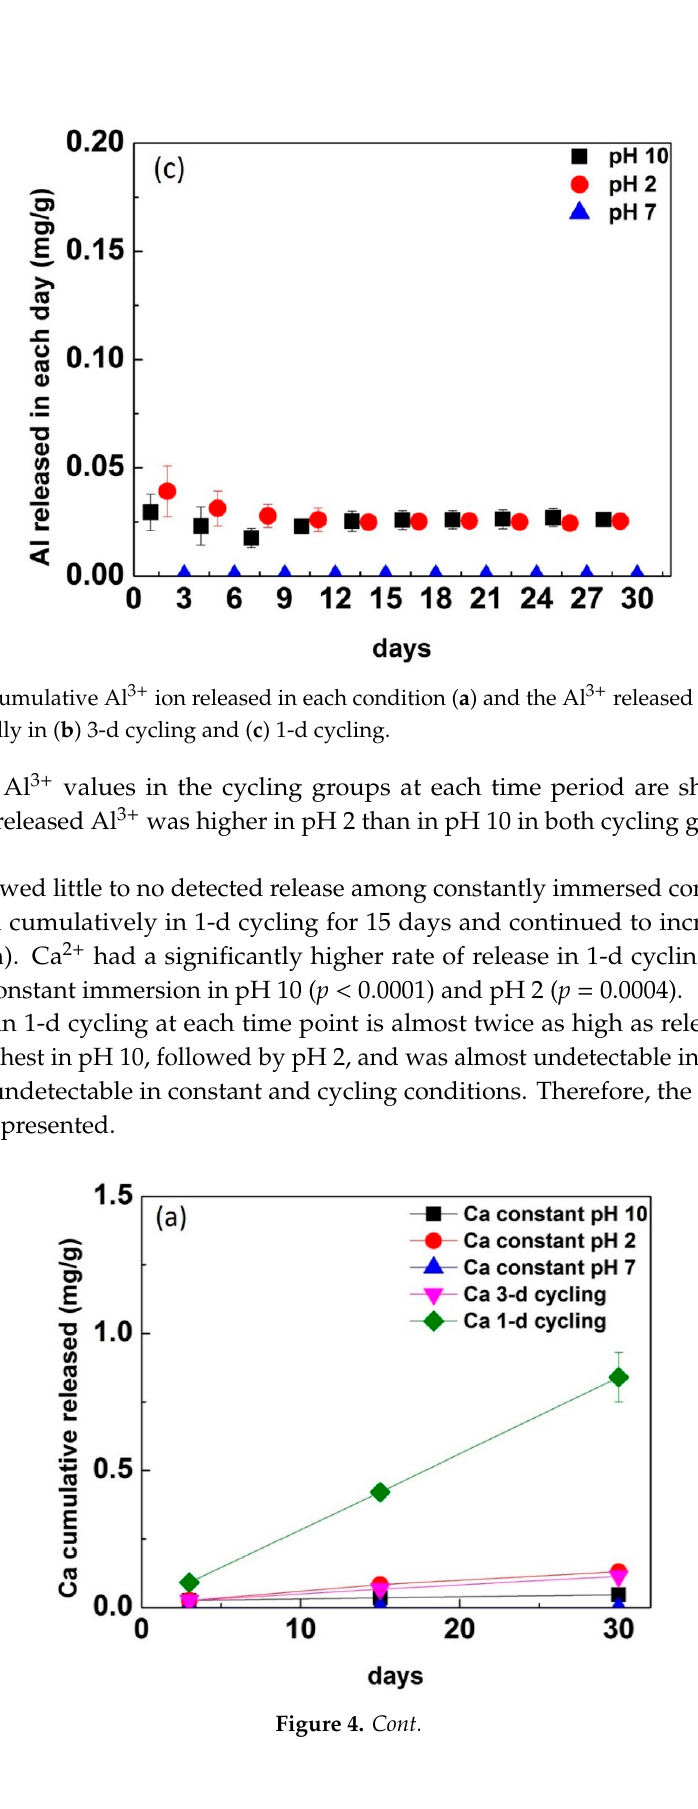
Figure 4. The cumulative Ca 2+ ion released in each condition ( a ) and the Ca 2+ released in each pH and time individually in ( b ) 3-d cycling and ( c ) 1-d cycling.